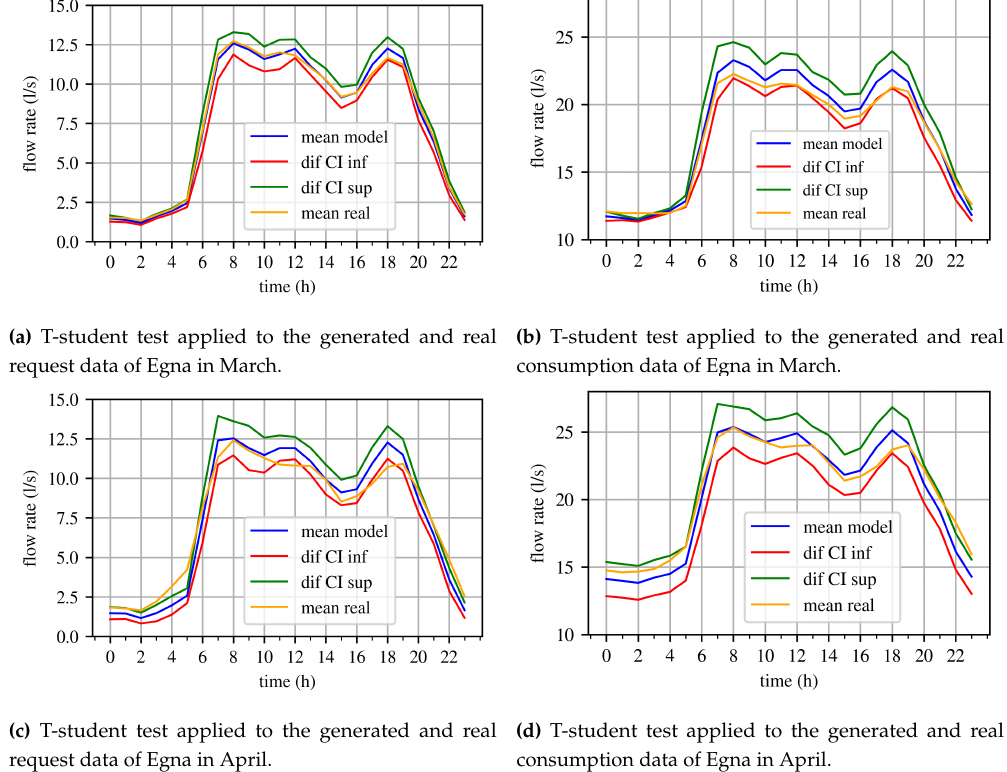
Figure 12. T-student test between generated and real data of March and April for both water request and consumption.